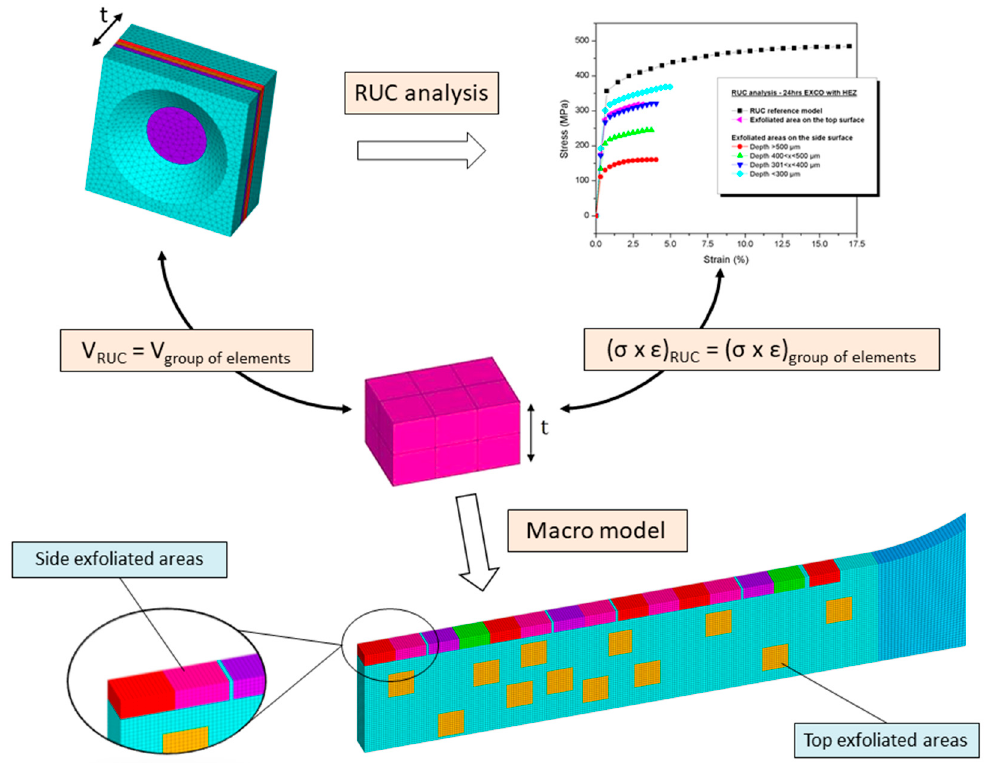
Figure 9. Sequence of introduction of corrosion damage into the specimens’ FE models.